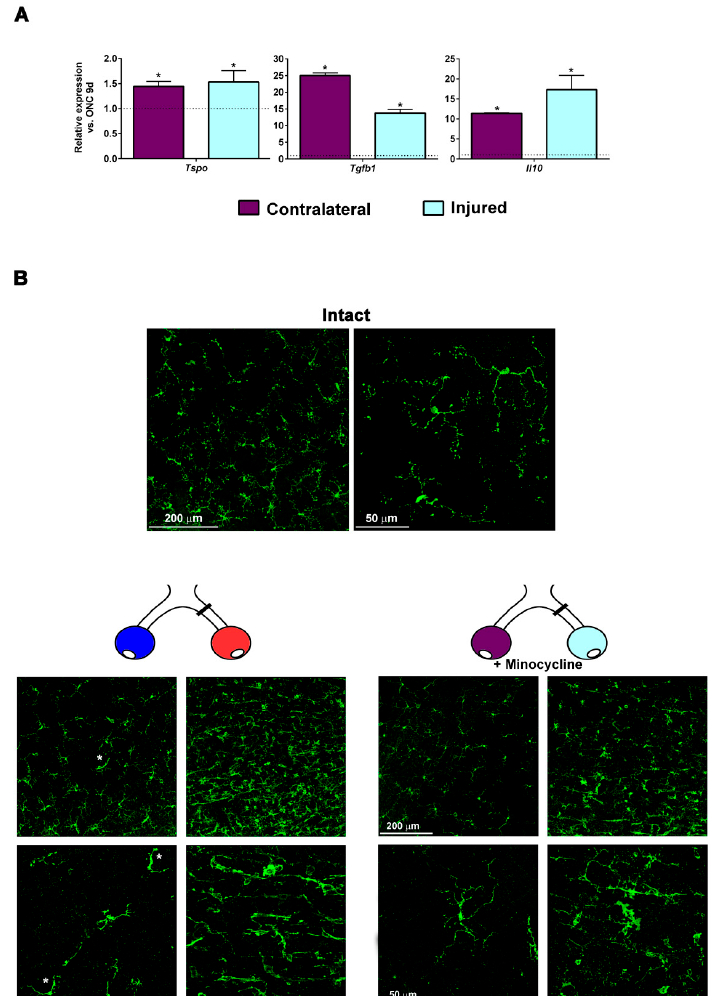
Figure 7. Minocycline treatment reduced microglial activation and increased the expression of M2 microglial transcripts and of anti-inflammatory mediators. ( A ) Bar graphs showing the expression level ± S.E.M. of Tspo (translocator protein 18kDa), Tgfb1 (transforming growth factor β 1) and IL10 (interleukin 10) transcripts in the injured (ice blue) and contralateral (purple) retinas from the ONC + minocycline 9 day group compared to the ONC 9 day group (dotted line, value 1). * p < 0.05 compared to ONC 9 days (t- test). n = 4 retinas per group. ( B ) Confocal images from flat mounts showing Iba1 + microglial cells in intact, contralateral, and injured retinas analyzed 9 days after ONC 2 mm and treated or not treated with minocycline. In the contralateral retinas of untreated animals, some microglial cells showed signs of activation (asterisks) such as bipolar morphology and a bigger soma, an activation that was not observed in minocycline-treated animals. In the injured retinas, microglial activation looked similar in treated and untreated retinas, however minocycline treatment reduced the number of microglial